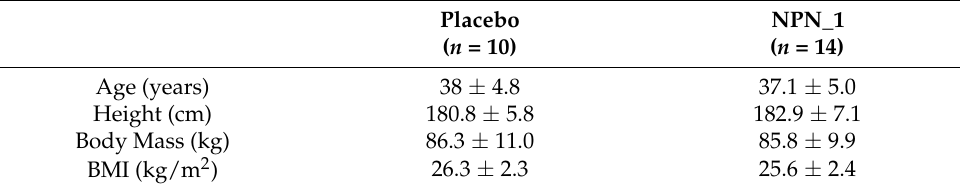
Table 3. Anthropometric data (mean ±